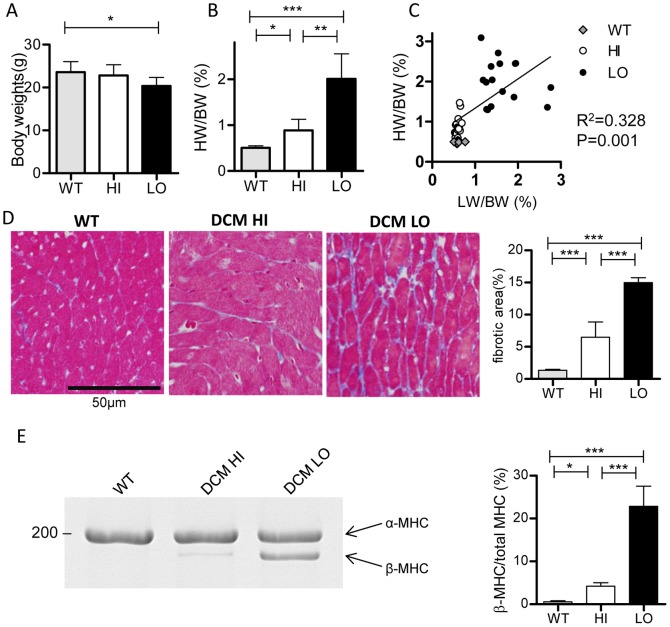
Heart weights, myocardial fibrosis, and protein expression level of β-MHC in myocardium.
A. Body weight. B. HW/BW ratio. Data are mean±SD. *P<0.05, **P<0.01, ***P<0.001. C. HW/BW to LW/BW ratio relationship. Linear regression revealed a positive correlation between HW/BW and LW/BW in all DCM mice (P = 0.001). D. Histological analysis of the fibrosis in left ventricular myocardium. Connective tissues were stained blue with azan. Left three panels: representative data from WT and DCM HI and LO group mice. Right: Averaged fibrosis area. Data represent the mean±SD for three mice. E. Protein expression level of β-MHC in left ventricular myocardium. Left: Representative Coomassie brilliant blue staining pattern of α- and β-MHC in individual experiments. Right: Averaged expression levels. The expression level for β-MHC was normalized to the total MHC (α-MHC+β-MHC). Data are means±SD (WT: n = 4, DCM: n = 5). *P<0.05, **P<0.01, ***P<0.001 vs. WT.